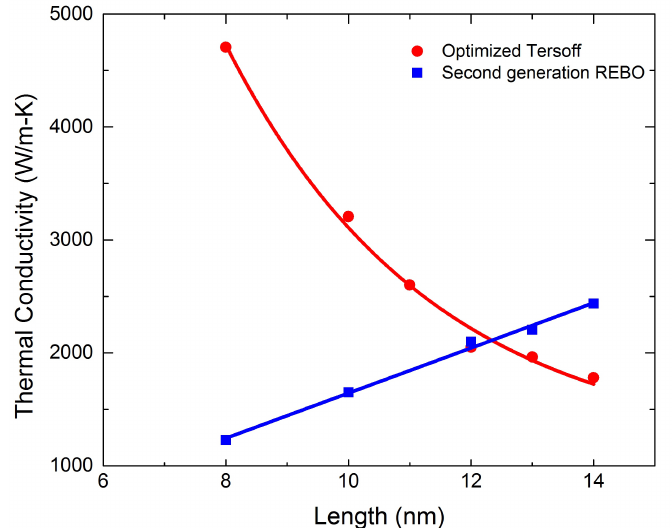
Figure 7. Thermal conductivity variation of GNR with length using optimized Tersoff and 2nd generation REBO potentials at 300 K temperature. The width of GNR is 1